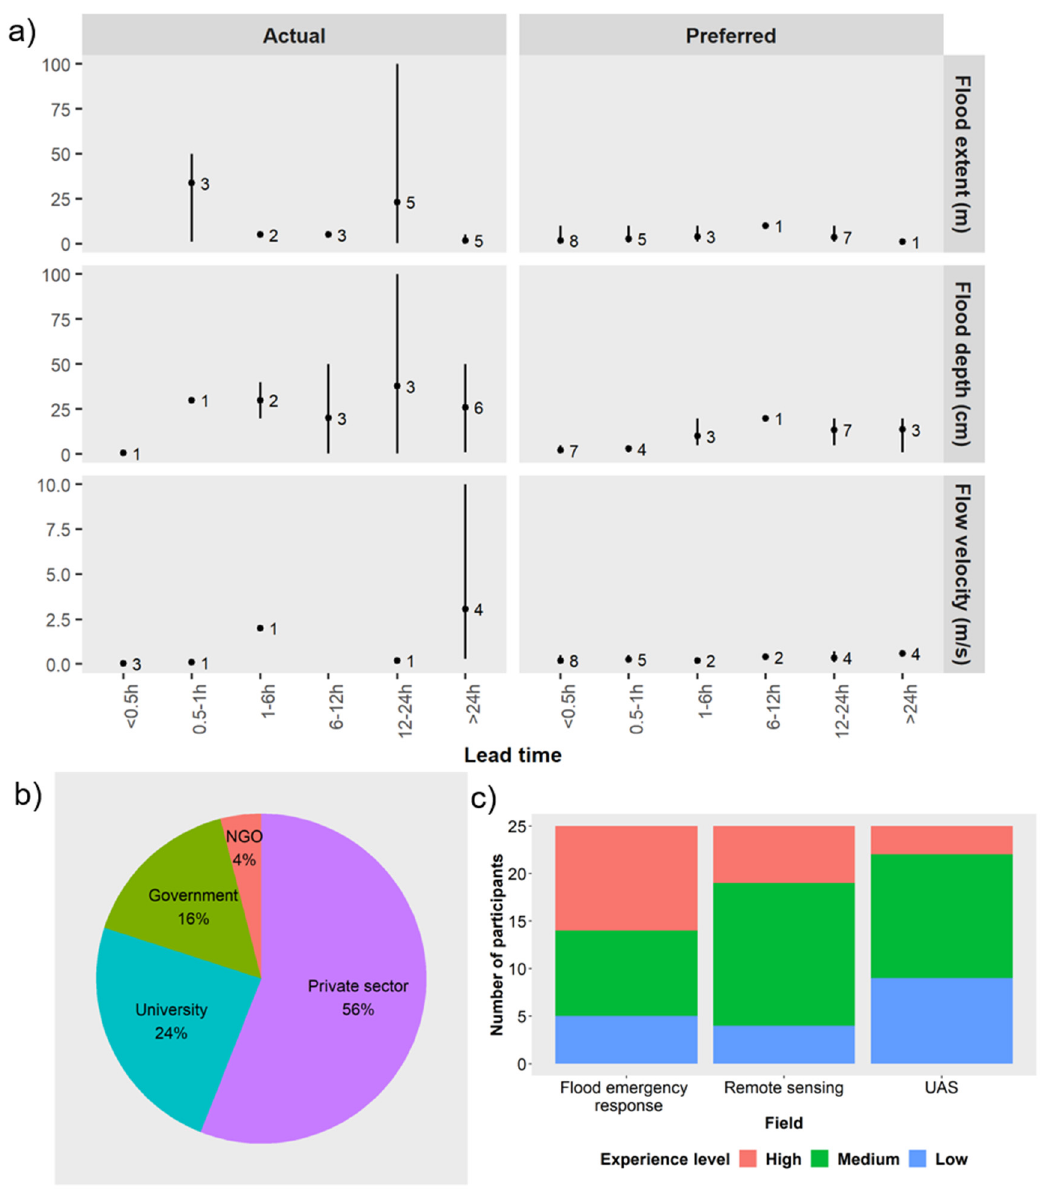
Figure 5. ( a ) Actual and preferred accuracy values and time needed to process flood extent, flood depth and flow velocity. The marker indicates the average of flood extent, flood depth and flow velocity, whereas the vertical lines shows the minimum and maximum values. The number of participants with a preference for a given combination are indicated against each measure. ( b ) Type of organizations that completed the survey. ( c ) Participants’ experience level in flood emergency response, remote sensing and UAS. Results obtained from 25 participants.